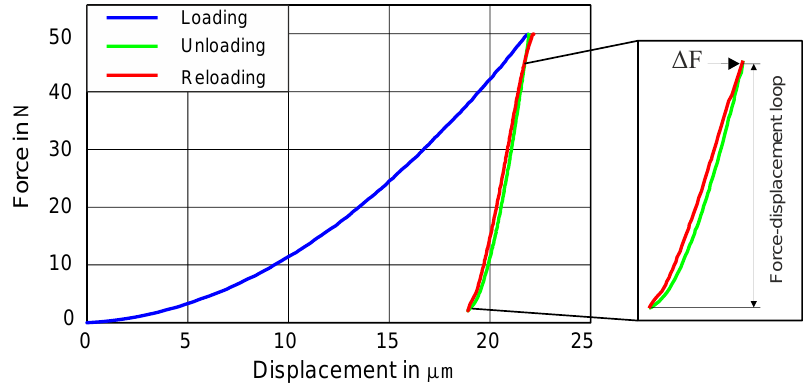
Figure 2. Force – displacement curve from the cyclic indentation curve. Components of the cycle are shown in different colors for clarity.